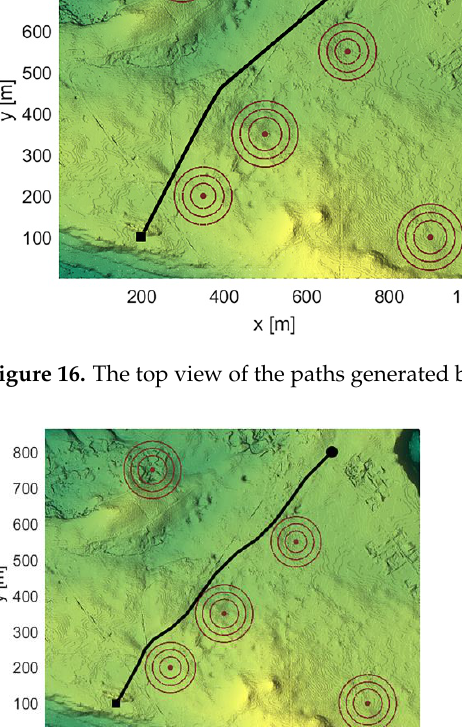
Figure 19. The top view of the path generated by the fourth set of data for the PSO algorithm. Figure 20. The top view of the path generated by the fourth set of data for the IC-VAINDIWPSO algorithm.